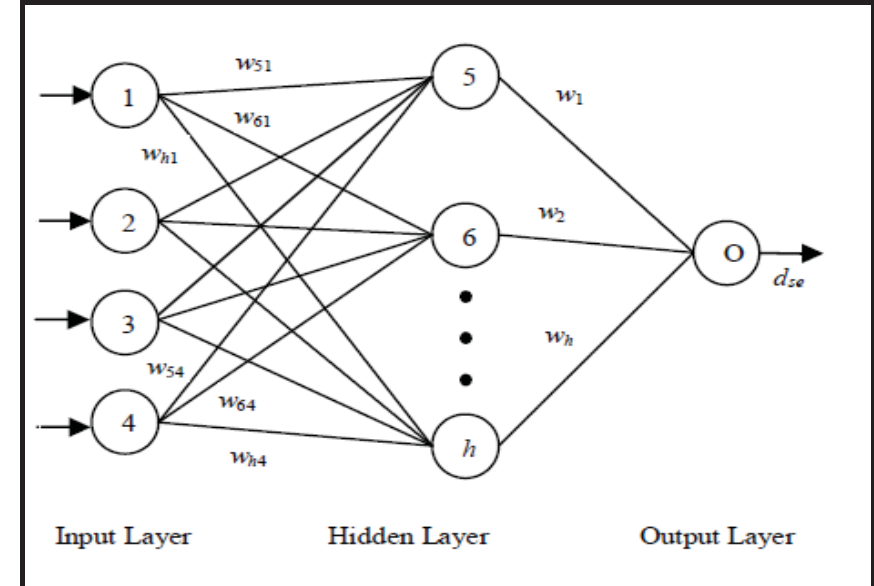
Fig. 1. A simple 3-layer feedforward neural